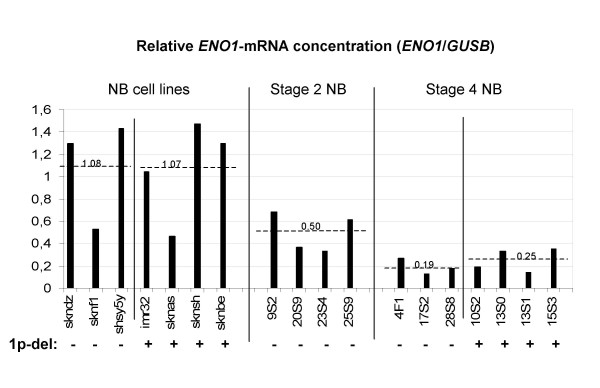
Expression of ENO1 in neuroblastoma cell lines and primary neuroblastoma tumours using real-time-PCR. Relative concentrations of ENO1-mRNA in relation to the concentration of the housekeeping gene GUSB for each sample are indicated on the y-axis. The samples are grouped into five groups: neuroblastoma cell lines, with and without 1p-deletion; stage 2 tumours; stage 4 tumours, with and without 1p-deletion. The 1p-deletion-status of each sample is indicated at the bottom. For each group the average value is indicated by a dotted line. A difference in expression could be detected between stage 2 tumours and stage 4 tumours (p = 0.01). No difference in expression could be detected between 1p-deleted samples and not 1p-deleted samples.